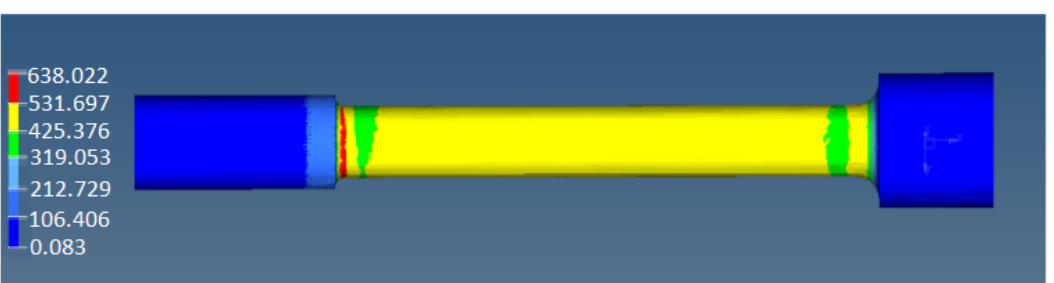
Figure 18. Elasticity modulus distribution in the 5th metatarsal bone — top: medial view; bottom: sagittal cutting with a headless screw. According to [29], simulation revealed that the critical equivalent von Mises stress can be detected at the notch of the screw; see Figures 19 and 20.